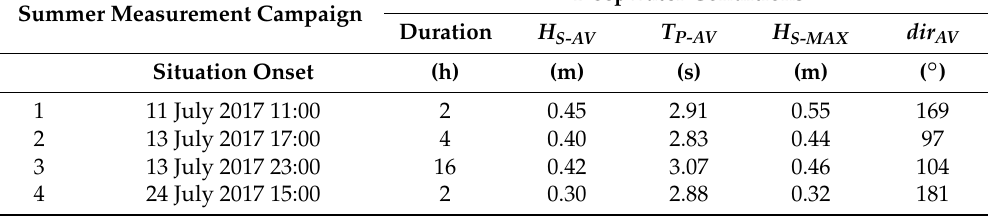
Table 3. Start date of each relevant wave situation (adopted criteria H S ≥ 0.3 m; T P ≥ 2.8 s; incident waves ranging from 90° to 180°), its duration, corresponding average significant wave height, peak period, maximum significant wave height and as wave direction recorded at ADCP 1 for the summer period.